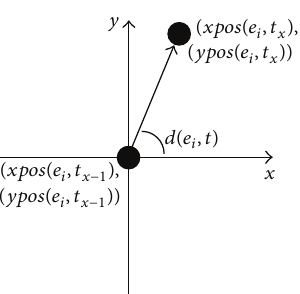
Figure 4: 𝑑(𝑒 𝑖 , 𝑡) : angle of entity 𝑒 𝑖 at a time-point 𝑡 .